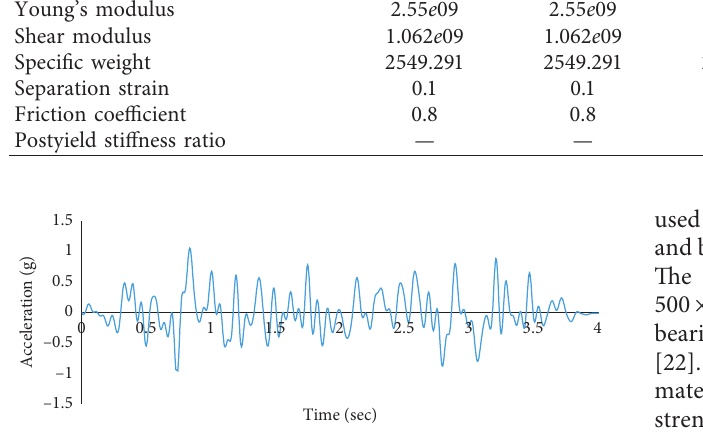
Figure 7: Artificial earthquake ground motion